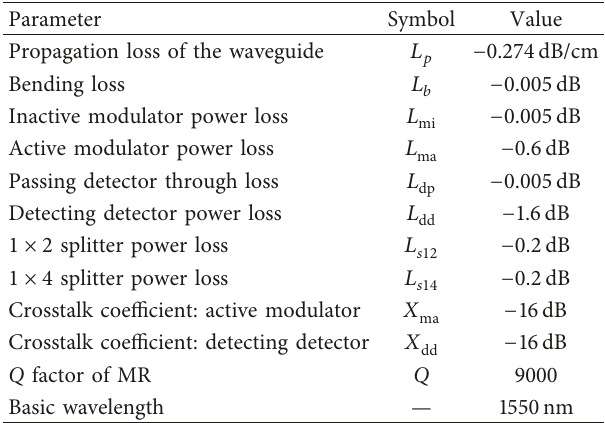
Table 1: Parameters of optical